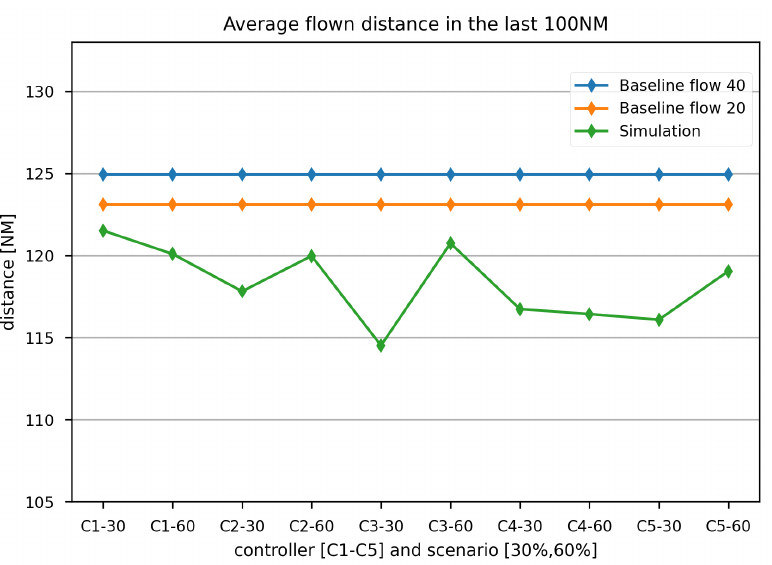
Figure 7. Flight trajectory results obtained under the simulation conditions (green) and compared with real traffic reference values for flows of 40 aircraft per hour (blue) and 20 aircraft per hour